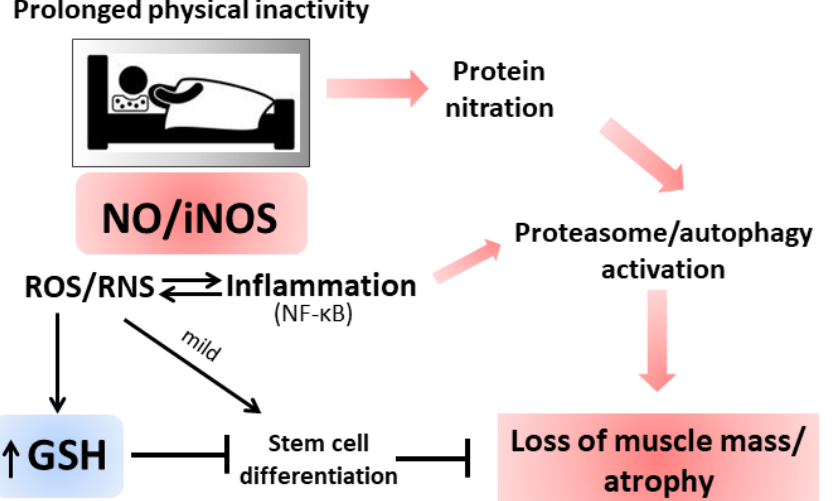
Figure 4. Oxidative/Nitrosative stress during prolonged physical inactivity. For details see the